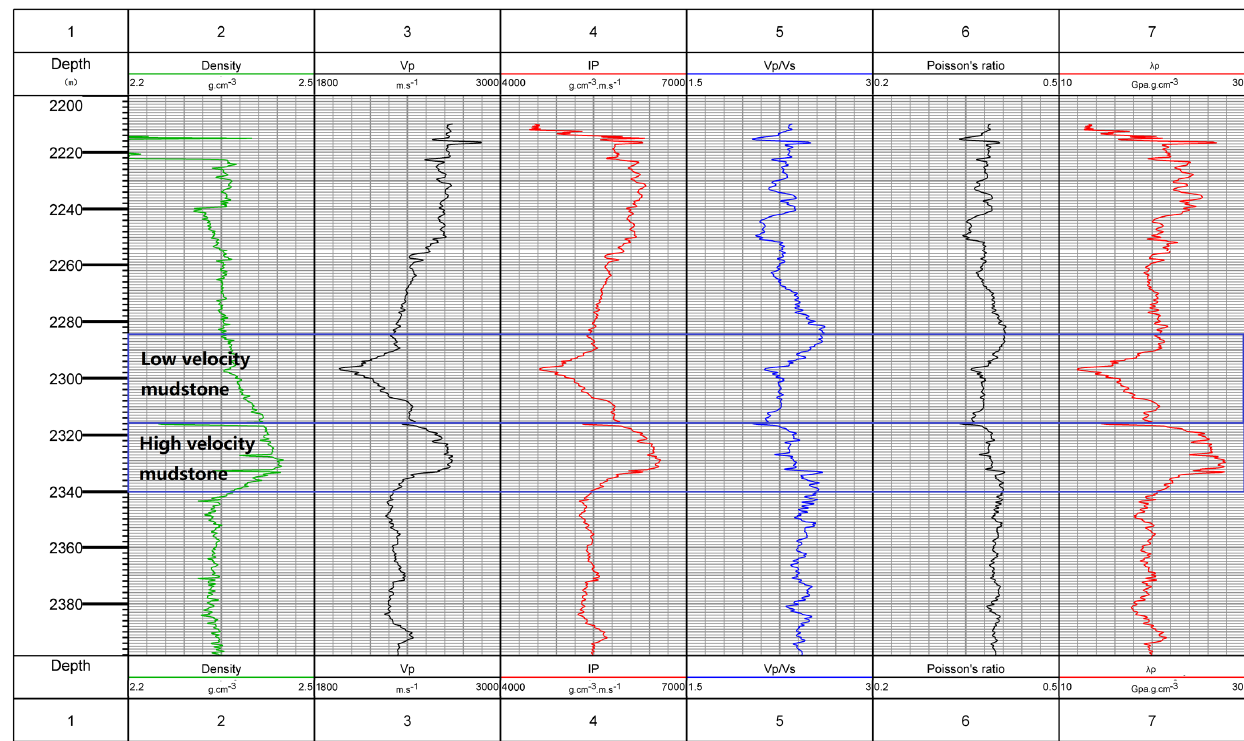
Figure 14. Logging curve of well LD23-X1.